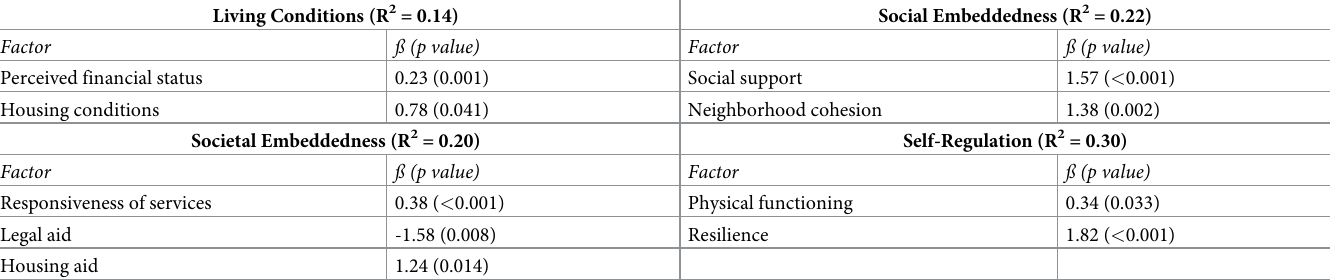
Table 3. US condition-specific models: Factors within each condition that are independently associated with quality of life. Living Conditions (R 2 = 0.14)